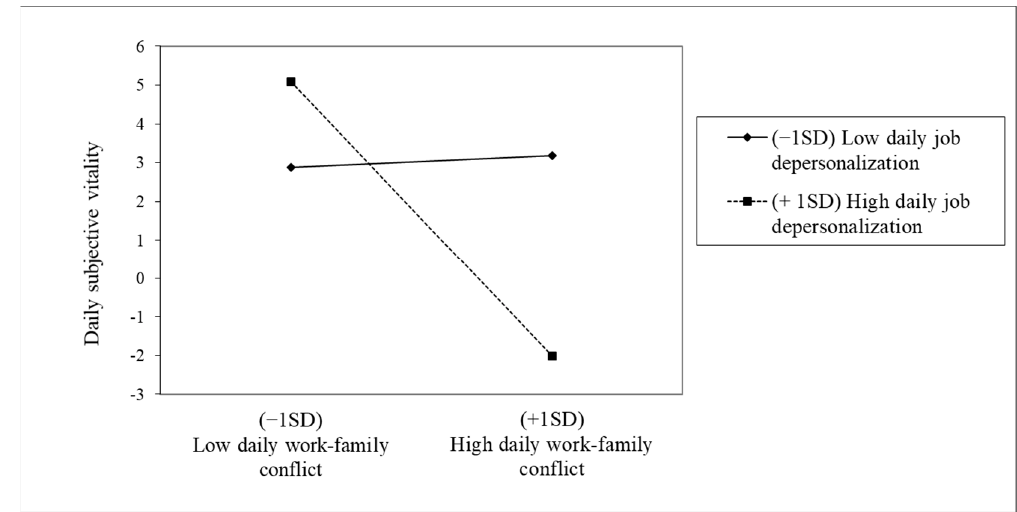
Figure 4. Interaction effects of Daily work-family conflict and Daily job depersonalization in explaining Daily subjective vitality.